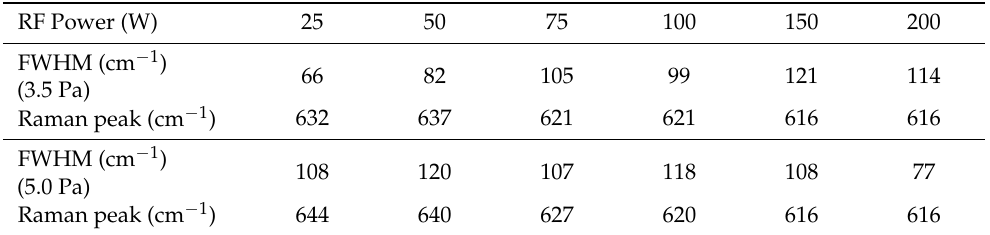
Table 5. Main parameters of Cu 3 N films RF power derived from the Raman spectra.